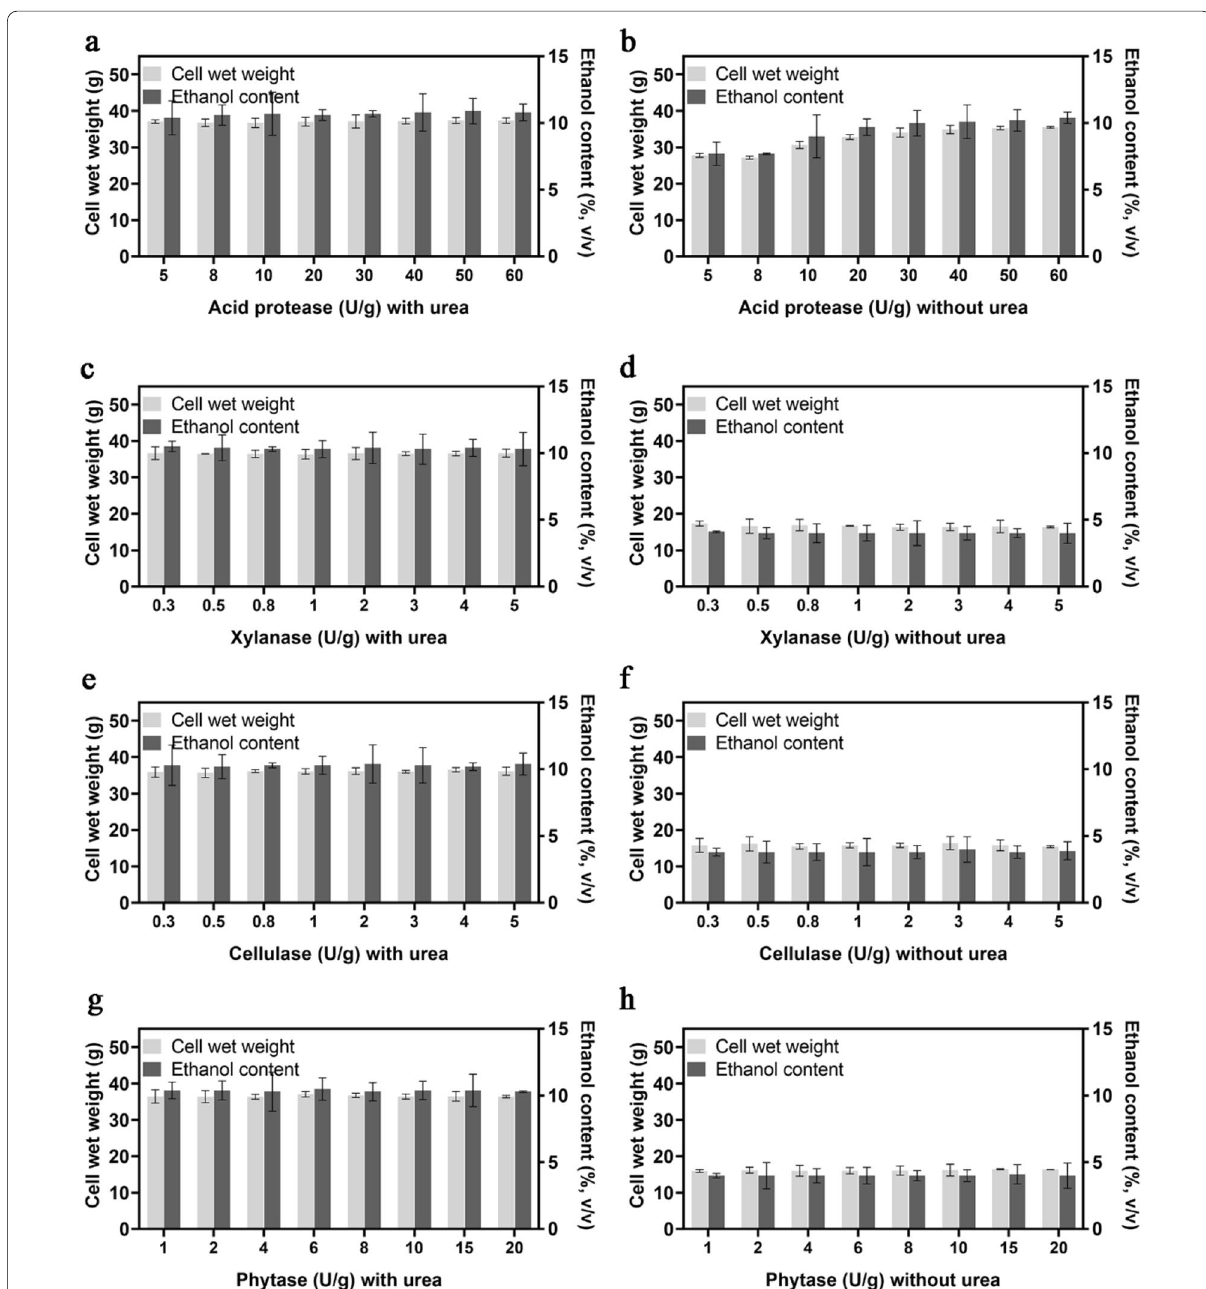
Fig. 6 Effect of microbial enzymes on the cell wet weight and ethanol content of glucoamylase expressing strain CIBTS1522. The influence of the acid protease addition with ( a ) or without urea ( b ), the xylanase addition with ( c ) or without urea ( d ), the cellulase addition with ( e ) or without urea ( f ), and the phytase addition with ( g ) or without urea ( h ) was shown. Error bars represent the standard deviation from the mean of three